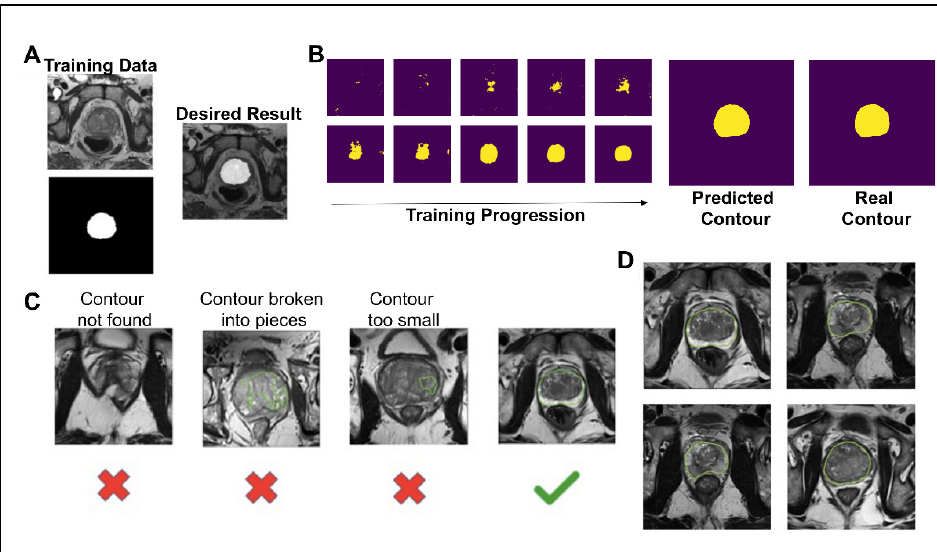
Figure 2. ( A ) Example of training data for the image segmentation neural network and the desired result. The top left is the T2 tse training image, and the bottom left is the corresponding binary contour. ( B ) The deep learning image segmentation training progression is shown for one image of the training set. The final predicted contour had a dice similarity coefficient of 0.99 to the real contour. ( C ) To pass the deep learning segmentation pipeline, the predicted contour had to be one continuous contour greater than 10,000 pixels. ( D ) Examples of the 253 synthetic images that passed the deep learning segmentation pipeline, shown with the prediction boundary.